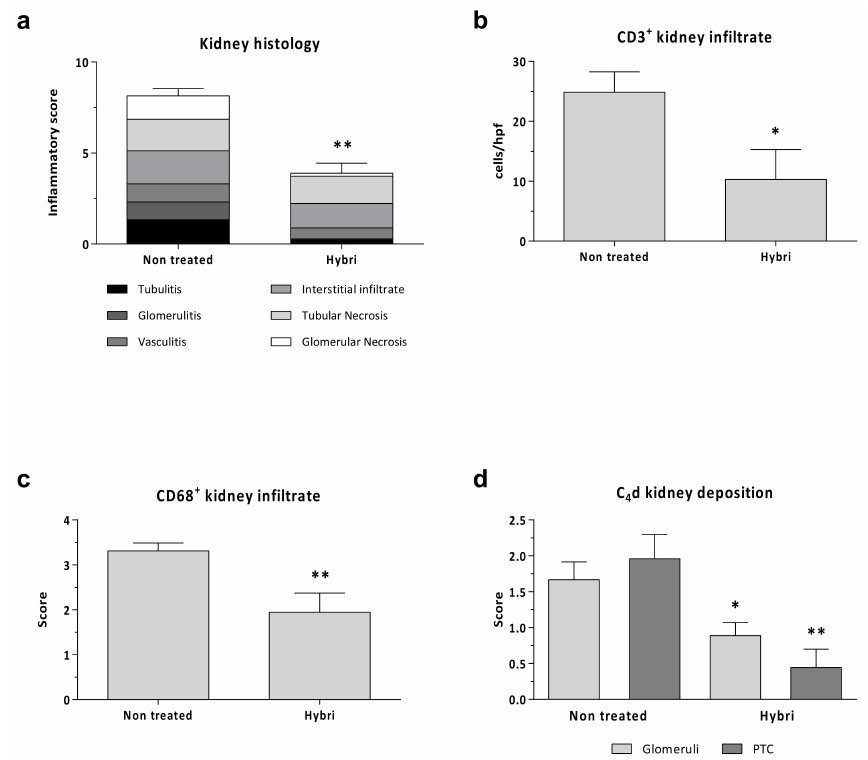
Figure 8. Renal histopathology parameters for allogeneic transplant model in the two studied groups. Semi-quantitative inflammatory score values ( a ) for Hematoxylin-Eosin stain. Cells per hpf values for renal immunofluorescence CD3+ ( b ) and semi-quantitative score for CD68+ surface intensity ( c ) and C4d kidney deposition ( d ). Data are expressed as a mean ± SEM. *, p < 0.05 vs. Non-treated; **, p < 0.01 vs.